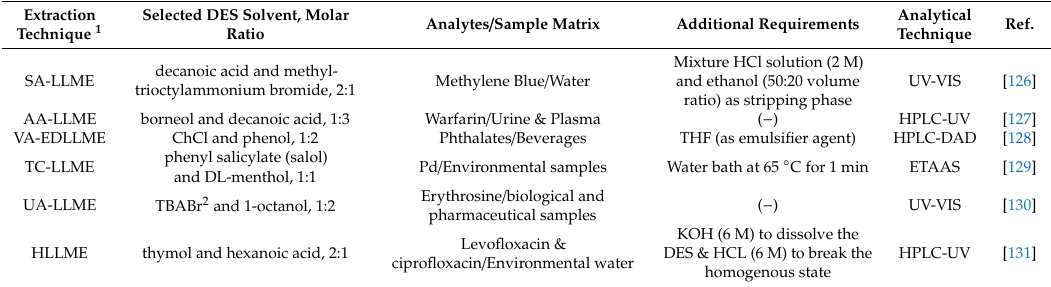
Table 2. Compilation of application of deep eutectic solvents (DES) in various types of liquid phase microextraction